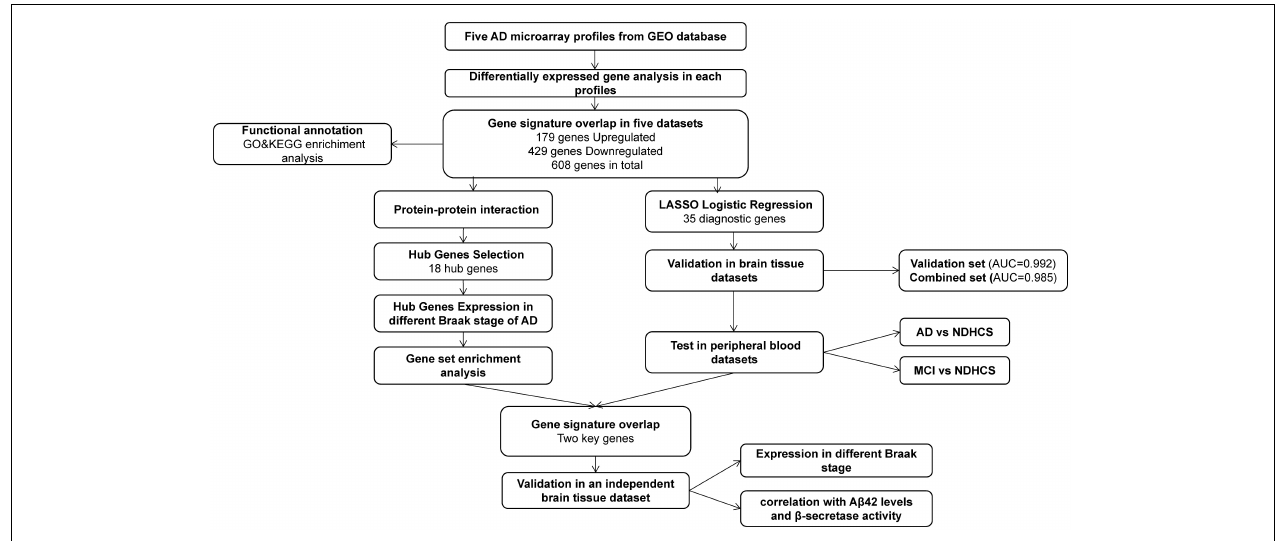
FIGURE 1 | Flowchart for bioinformatics analysis in this study. AD, Alzheimer’s disease; MCI, mild cognitive impairment; NDHCS, non-demented healthy control subjects; AUC, area under the curve; GSEA, gene set enrichment analysis; GEO, Gene Expression Omnibus; GO, Gene Ontology; KEGG, Kyoto Encyclopedia of Genes and